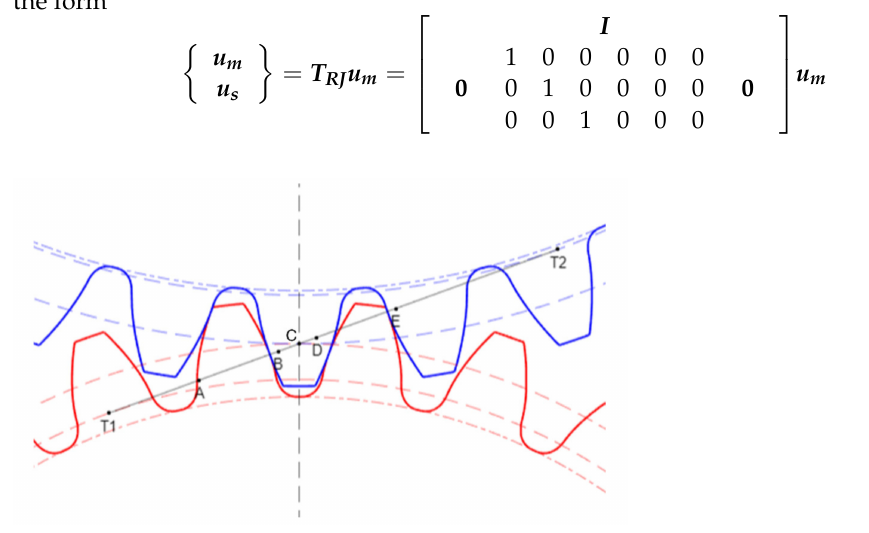
Figure 1. Location of points C , T 1 and T 2 during the